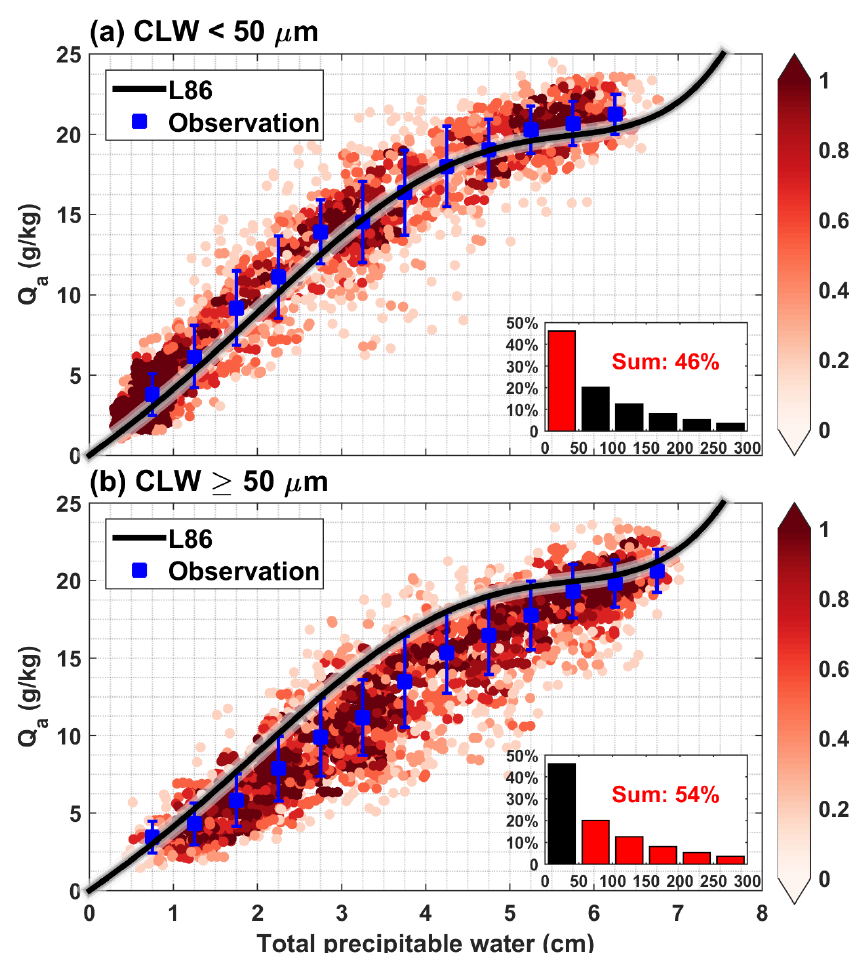
Figure 7. Scatter diagram of Q a (ordinate) and TPW (abscissa) for data under conditions of CLW ( a ) below and ( b ) above 50 μm. The black line denotes the L86 model. The red dot denotes the data density in each 0.5 cm bin of TPW and 0.5 g/kg bin of Q a with units of ‰. The blue square and error bar are the median and one STD of Q a in each bin of 0.5 cm of TPW, respectively. The bar plot is the probability density distribution of CLW, with red bars representing the data range used in the corresponding panel.